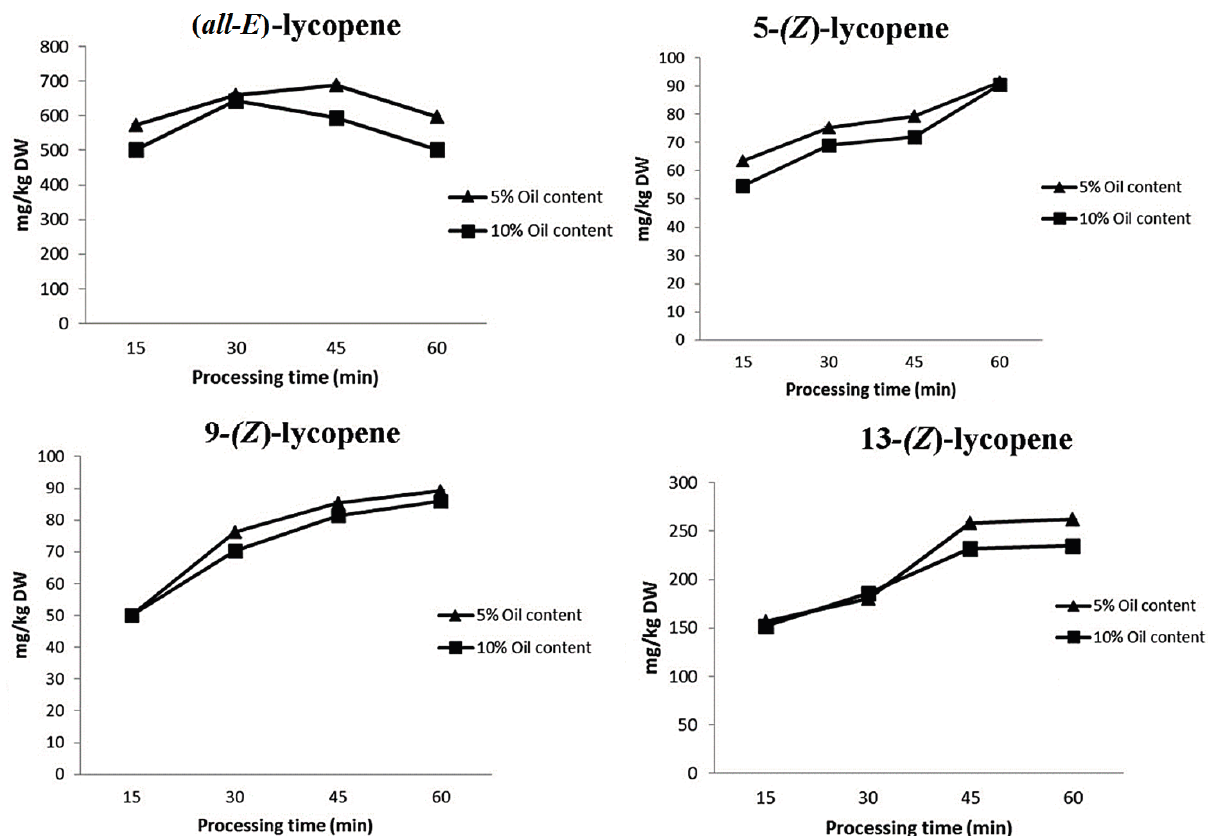
Figure 3. Changes in ( all-E )-lycopene and 5-( Z ), 9-( Z ) and 13-( Z )-lycopene during processing